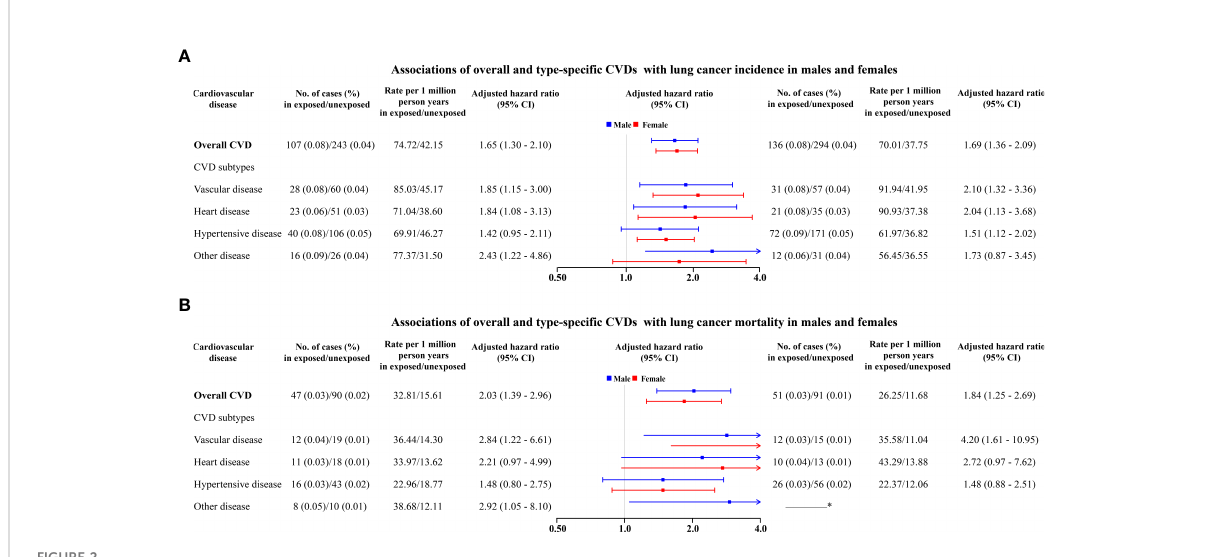
FIGURE 2 Associations of overall and type-speci fi c CVDs with lung cancer incidence (A) and lung cancer mortality (B) in males (left) and females (right). * The number of deaths from lung cancer is less than 6, which is not allowed to report due to privacy protection. Controlled for matching factors (age and sex) by design and adjusted for obesity, diabetes mellitus, smoking disorders, alcohol disorders, marital status, and educational